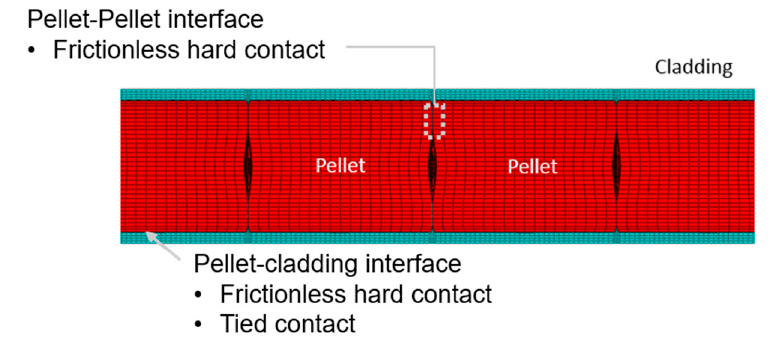
Metals 2020 , 10 , x FOR PEER REVIEW Figure 3. Detailed finite element model of the reference fuel rod segment. Figure 3. Detailed finite element model of the reference fuel rod segment.